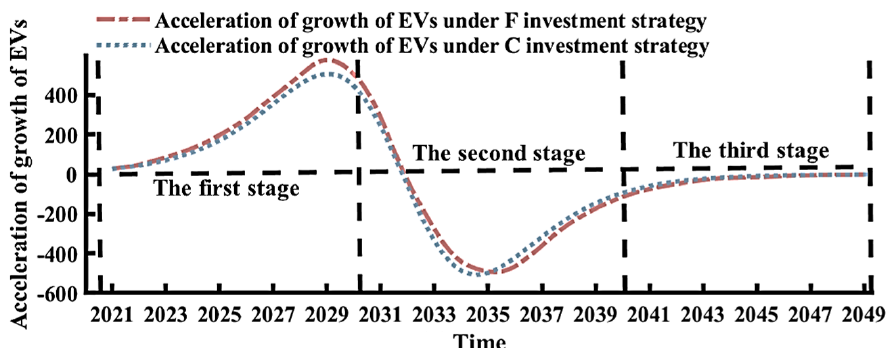
Figure 10. Three stage growth change of EV